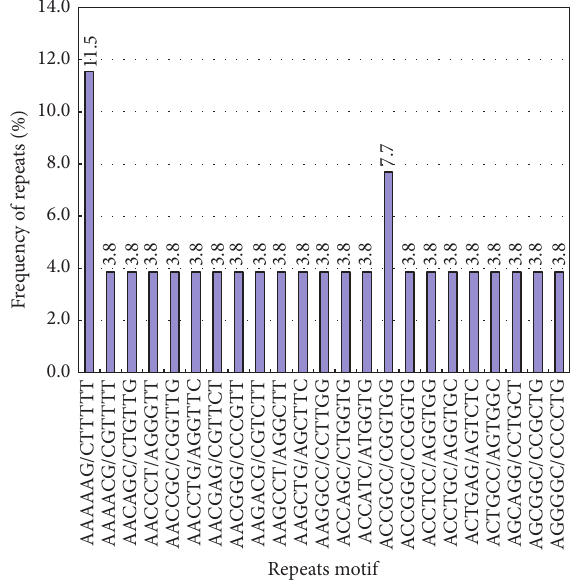
Figure 7: Hexanucleotide repeats of Unigene.